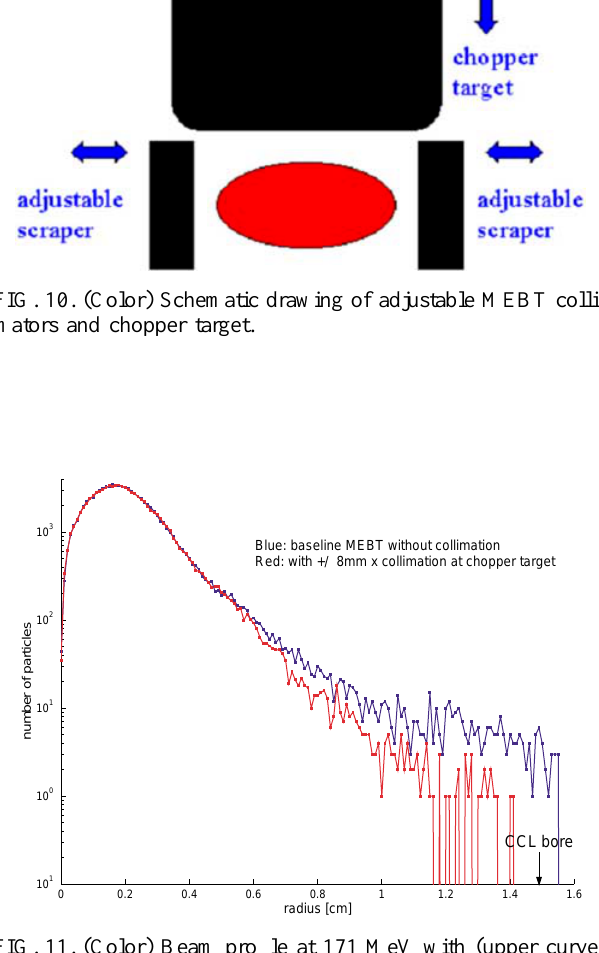
FIG. 11. (Color) Beam profile at 171 MeV with (upper curve) and without MEBT collimation (lower curve) at 6 8 mm. Halo is reduced by 84%. This means that 84% of the beam with r . 9 mm is removed. CCL bore radius is 1.5